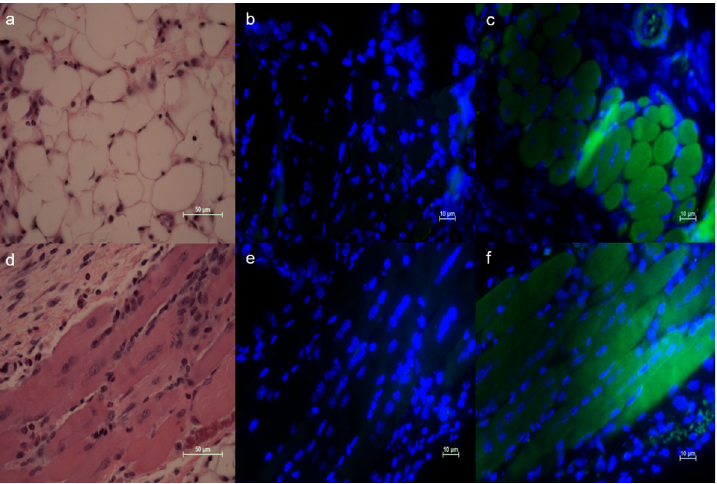
Fig 5. Microscopic localization of Tln2 in infected mouse wound bed. Tln2 was observed in adipocytes (a, b, c), and striated muscle (d, e, f). H&E staining (a, d), IHC negative control (b, e), IHC detection of Tln2 with Alexa Fluor 488 secondary (c, f). Nuclei were stained with DAPI. Scale bars are given for each